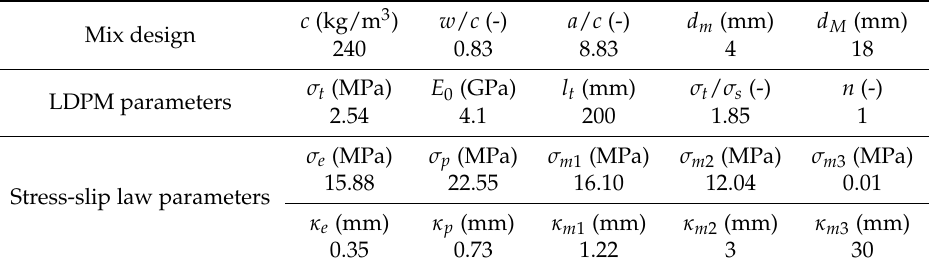
Figure 6. Numerical (Num) and experimental (Exp) results: ( a ) cylinder compression test; ( b ) cube compression test; ( c ) three-point bending test ( d ) Brazilian splitting test. CMOD, crack mouth opening displacement. Table 3. Calibration parameters of LDPM (top) and the stress-slip law